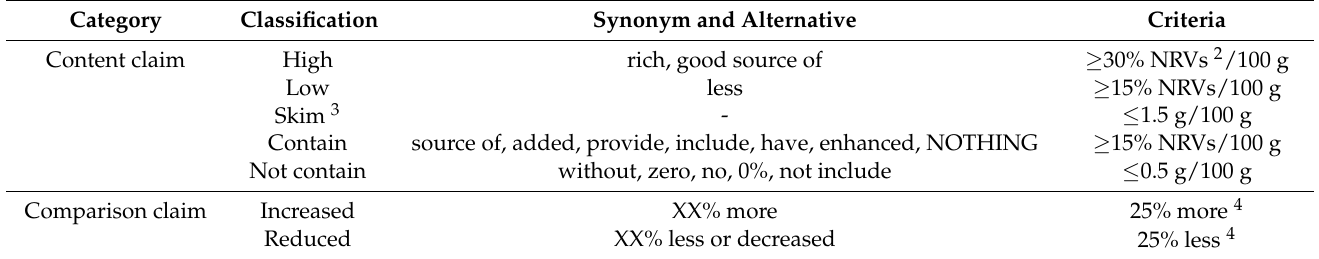
Table 2. Category, classification and criteria of nutrition claims according to GB 28050-2011 1